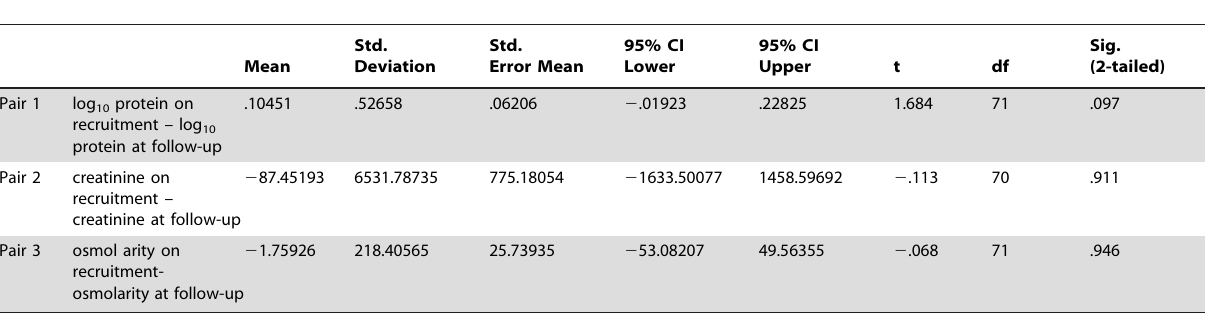
Table 2. Paired t-test comparing standard levels measured on recruitment and at follow-up.